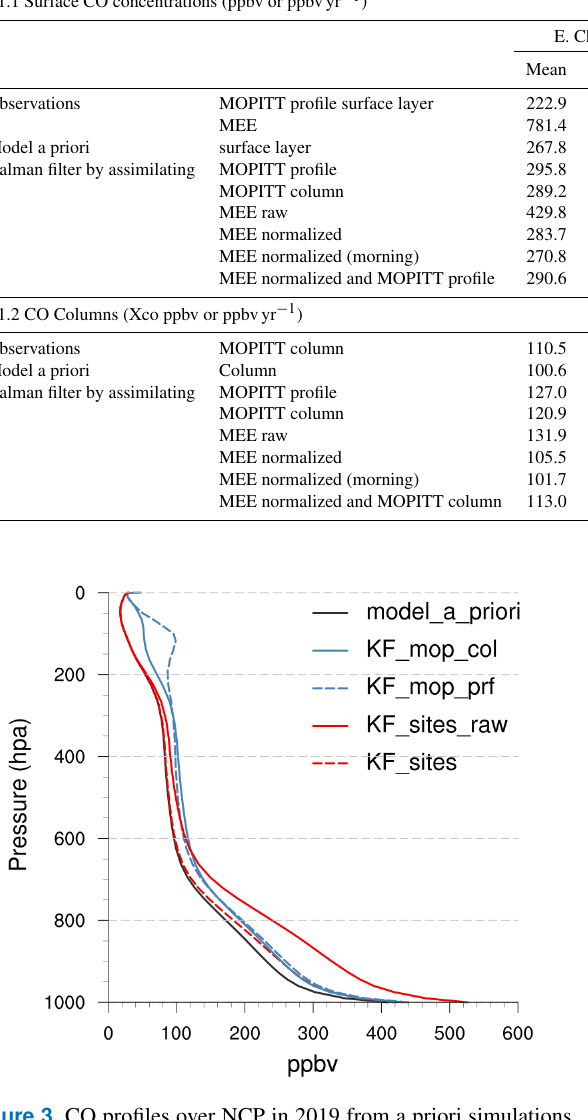
Figure 3. CO profiles over NCP in 2019 from a priori simulations (black line), Kalman filter by assimilating MOPITT CO (column: blue solid line; profile: blue dashed line) and MEE CO (raw data: red solid line; normalized data: red dashed